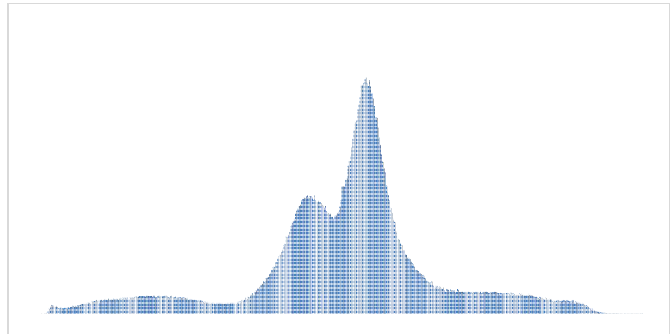
Figure 2. Histogram of differencing image